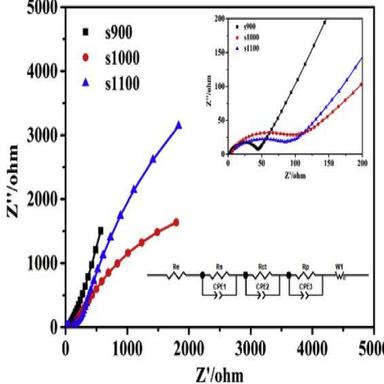
Electrochemical impedance plots of the electrodes at the charge state of 4.8V after 5 cycles. The inset shows the equivalent circuit, dot represents the experimental data, and the solid lines are the fitted data.